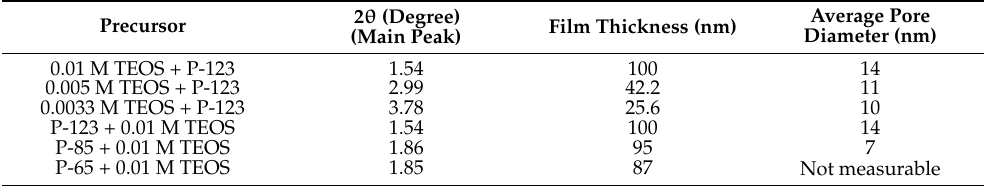
Figure 2. XRD graphs of mesoporous silica thin films using different Pluronics ( a ) P-123 ( b ) P-85 and ( c ) P-65. Table 1. Film thickness, pore sizes and peak positions of mesoporous silica thin films with varying experimental parameters.